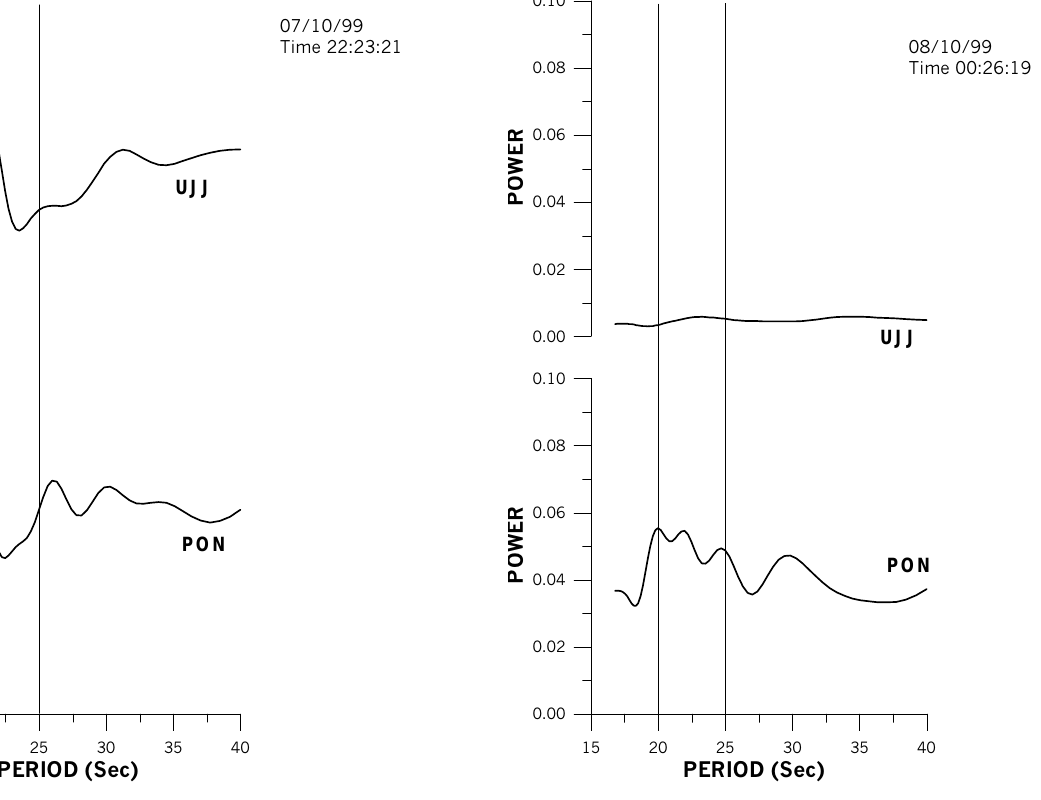
Fig. 3. Power spectrum of the 2 s averaged filtered scintillation on the specified day, at local time and at the specified stations. The plot shows the spectral peaks clearly standing out around the eigen- period. The range of the eigen-period has been marked by the inter- val between two vertical lines.